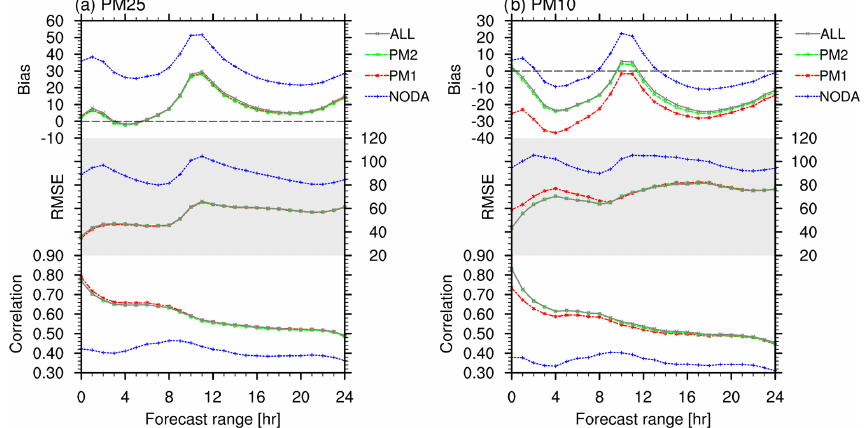
Figure 6. Averaged bias (units: µgm − 3 ), RMSE (units: µgm − 3 ), and correlation for (a) PM 2 . 5 and (b) PM 10 in different experiments as a function of forecast range, verified against the surface observations of 531 stations in China. The blue, red, green, and gray lines denote the results of experiment NODA, PM1, PM2, and ALL,